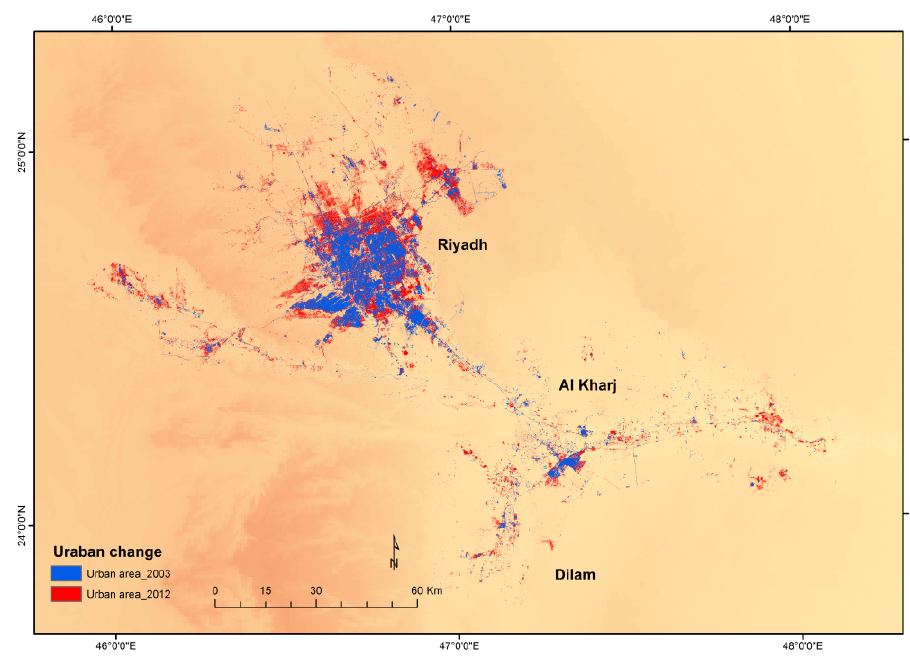
Figure 3. Urban expansion area in Riyadh.